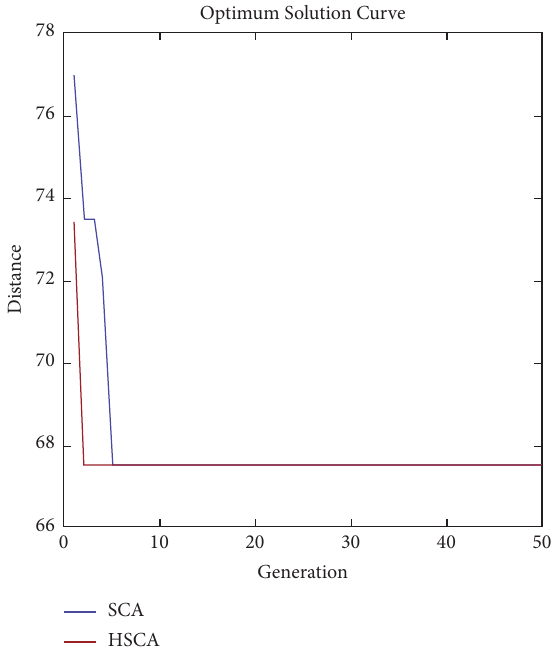
Figure 8: Optimal values obtained by the HSCA and SCA after 20 runs in case study 1. Table 2: Optimal results obtained with diferent algorithms after 20 runs in case study 1.